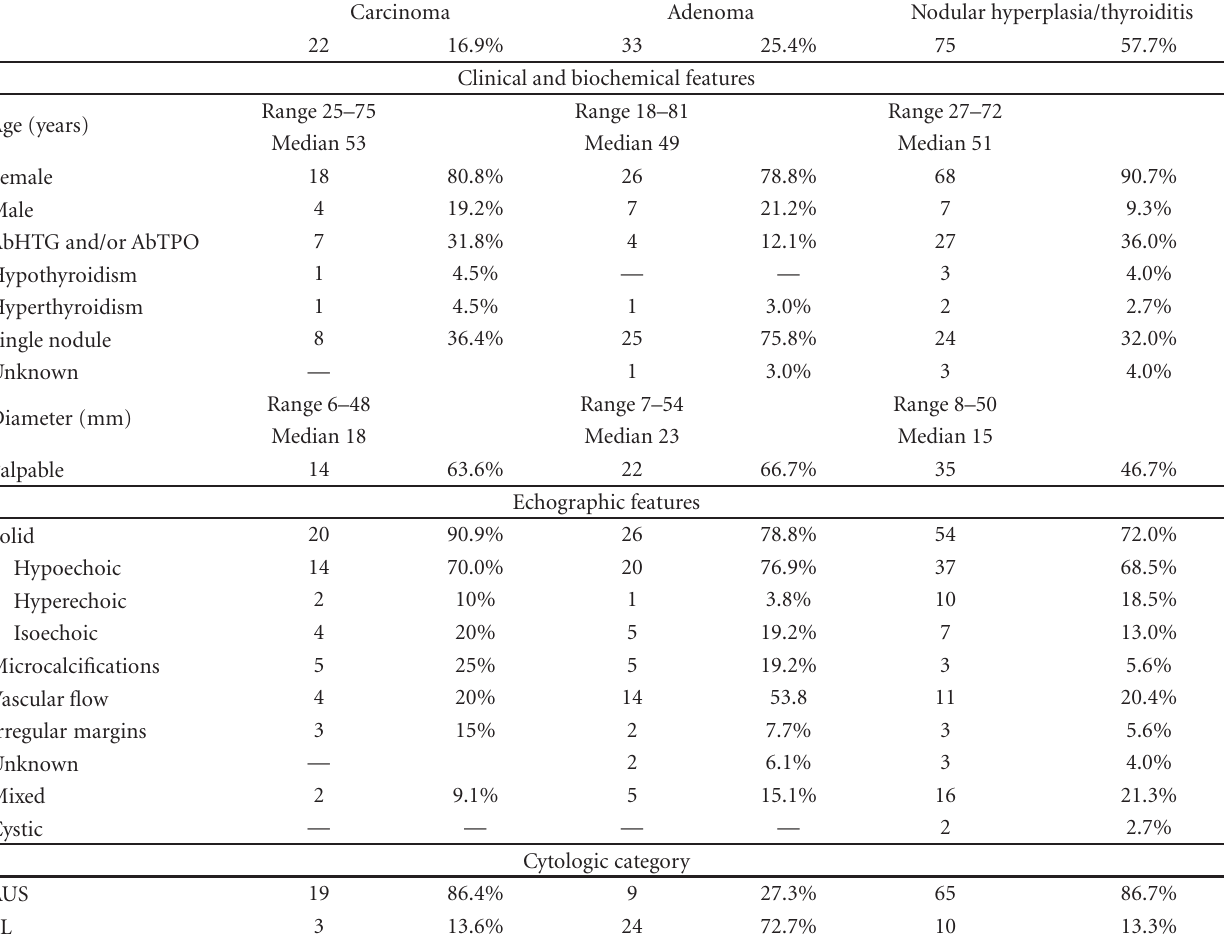
Table 2: Clinical, biochemical, and echographic features of 130 thyroid nodules with histological (81 cases) or benign repeated cytology with clinical-echographic followup (49